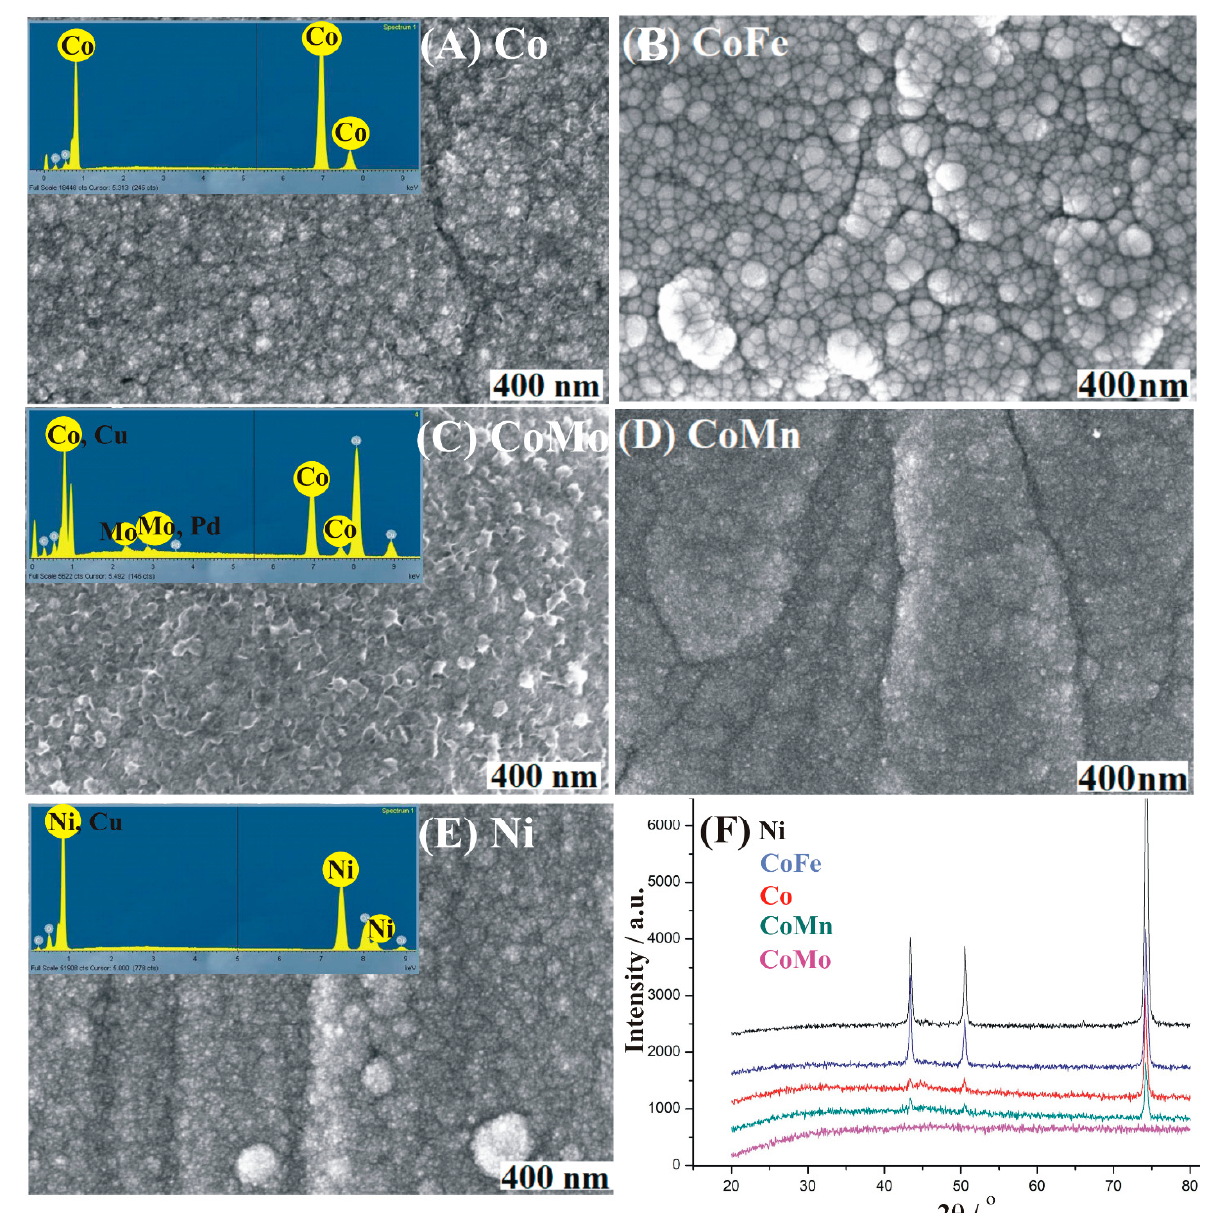
Figure 1. ( A – E ) SEM images (with EDX spectra in inset of ( A , C , E )) of the five prepared coatings and ( F ) their XRD patterns.